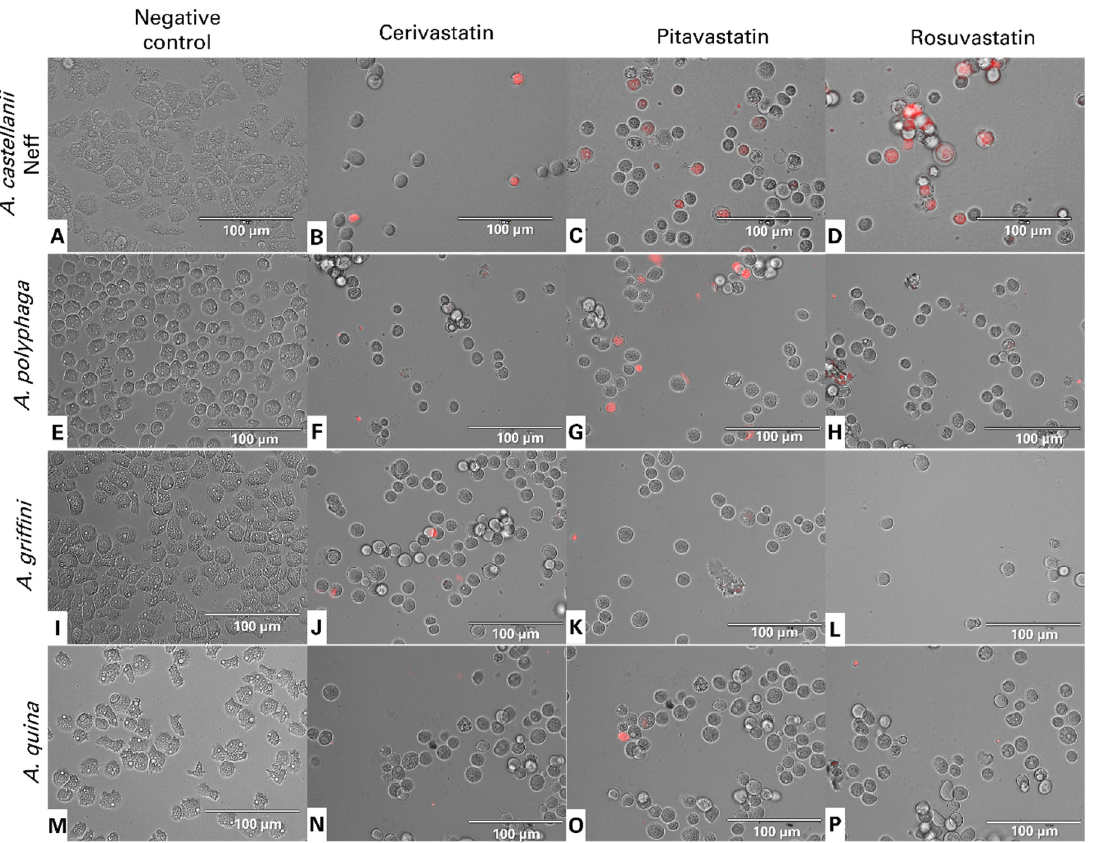
Figure 5. Detection of reactive oxygen species (ROS) in trophozoites of Acanthamoeba castellanii Neff ( A – D ), A. polyphaga ( E – H ), A. griffini ( I – L ) and A. quina ( M – P ), treated with the IC 90 of cerivastatin ( B , F , J , N ), pitavastatin ( C , G , K , O ) and rosuvastatin ( D , H , L , P ) for 24 h, and comparing with the negative control ( A , E , I , M ). CellROX™ Deep Red Reagent emitted bright red fluorescence in the presence of ROS. All images were captured using an EVOS FL Cell Imaging System EVOS™ M5000 (40×